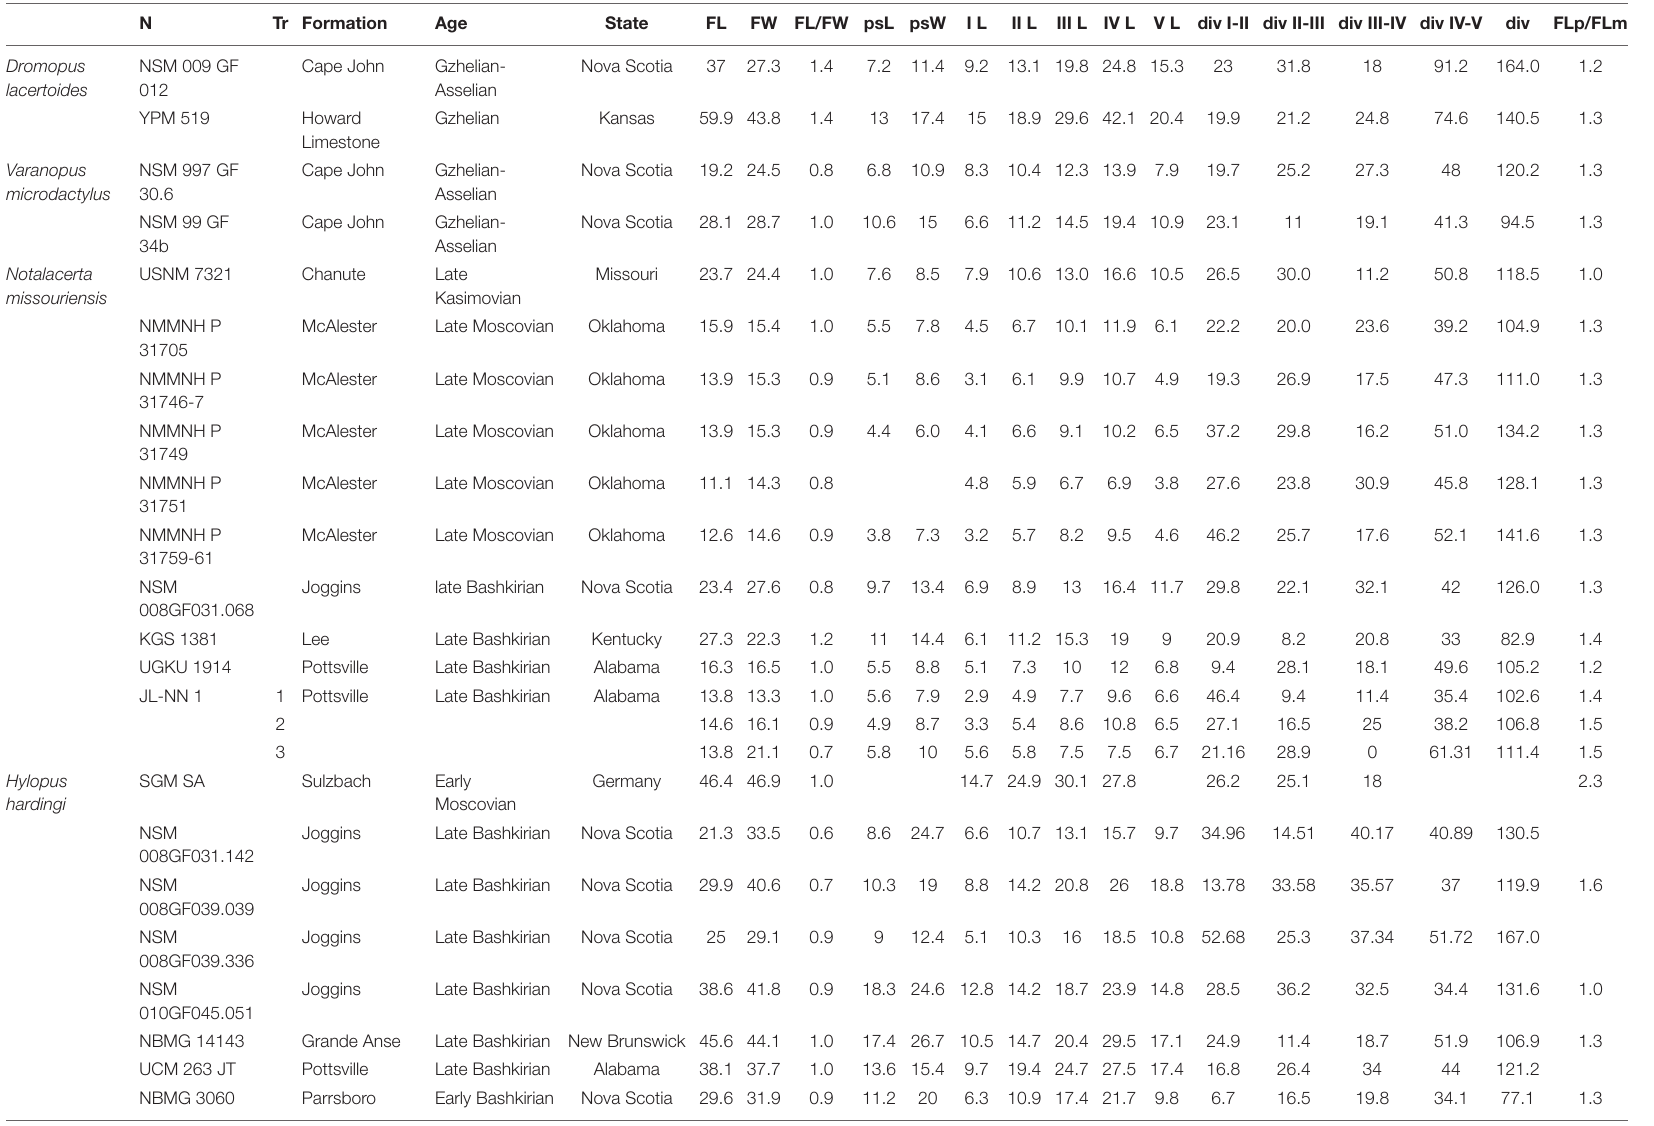
TABLE 2 | Ichnological parameters of manual footprints. N Tr Formation